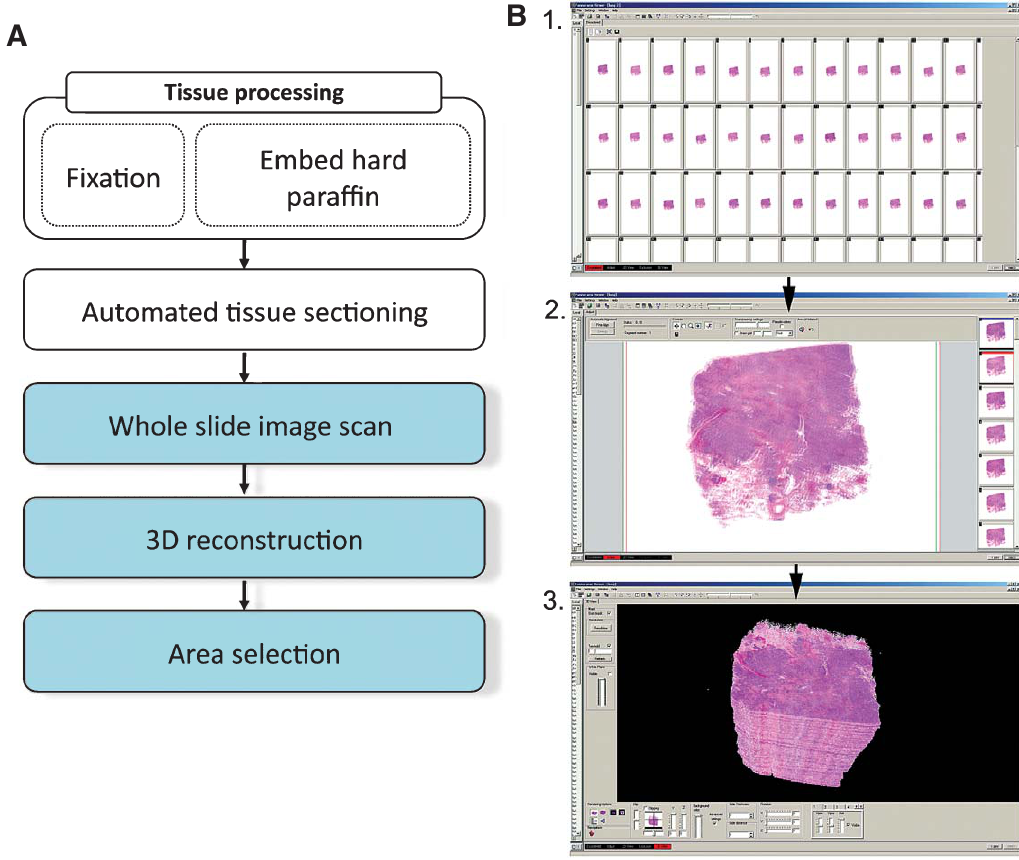
Fig. 1. Workflow for 3D-reconstruction. Tissue blocks are processed to be serial sectioned by the automated sectioning system. Once slides are sectioned and stained, they are scanned and whole slide images are obtained (A). With the 3D feature of the inbuilt software, stack of images are constructed (B-1) and aligned (B-2), imperfections (tissue debris) are selected and deleted from the stack and reconstruction is obtained